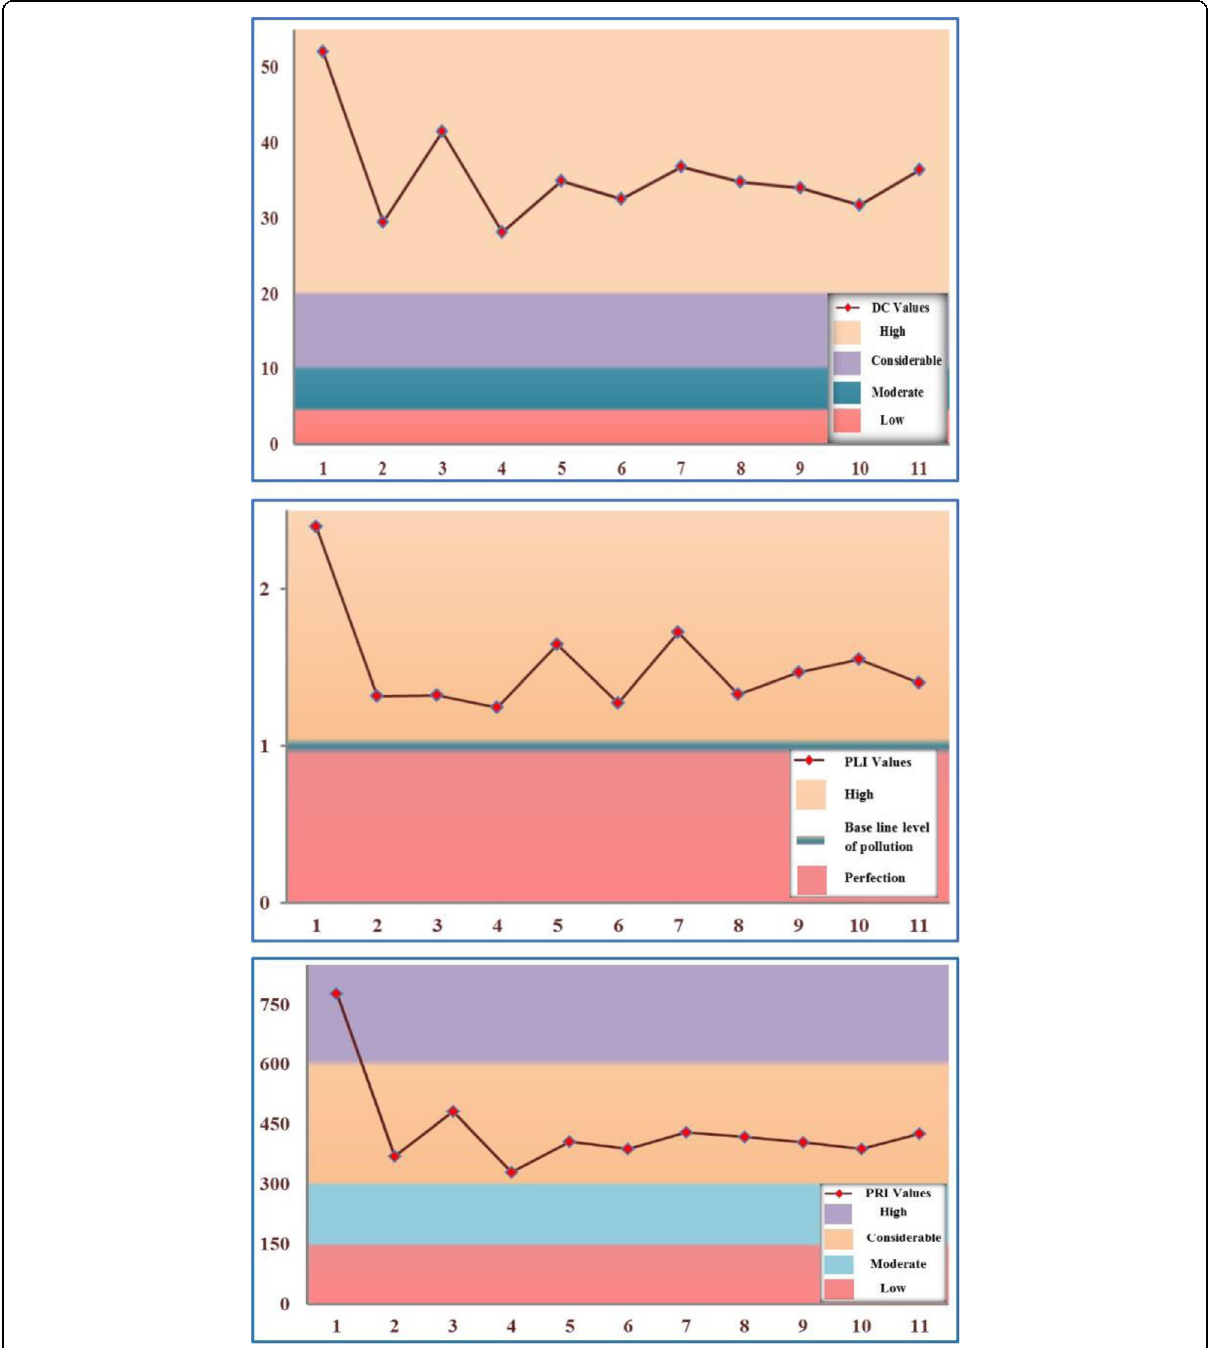
Fig. 8 DC, PLI, and PRI variations in Orabi